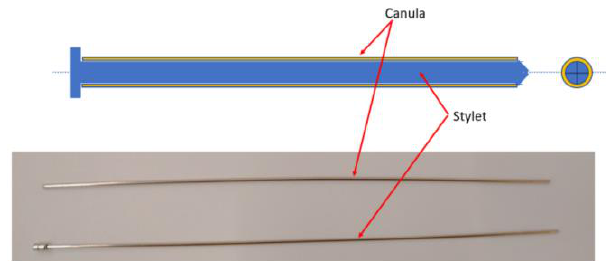
Figure 3. Components of the brachytherapy needle.